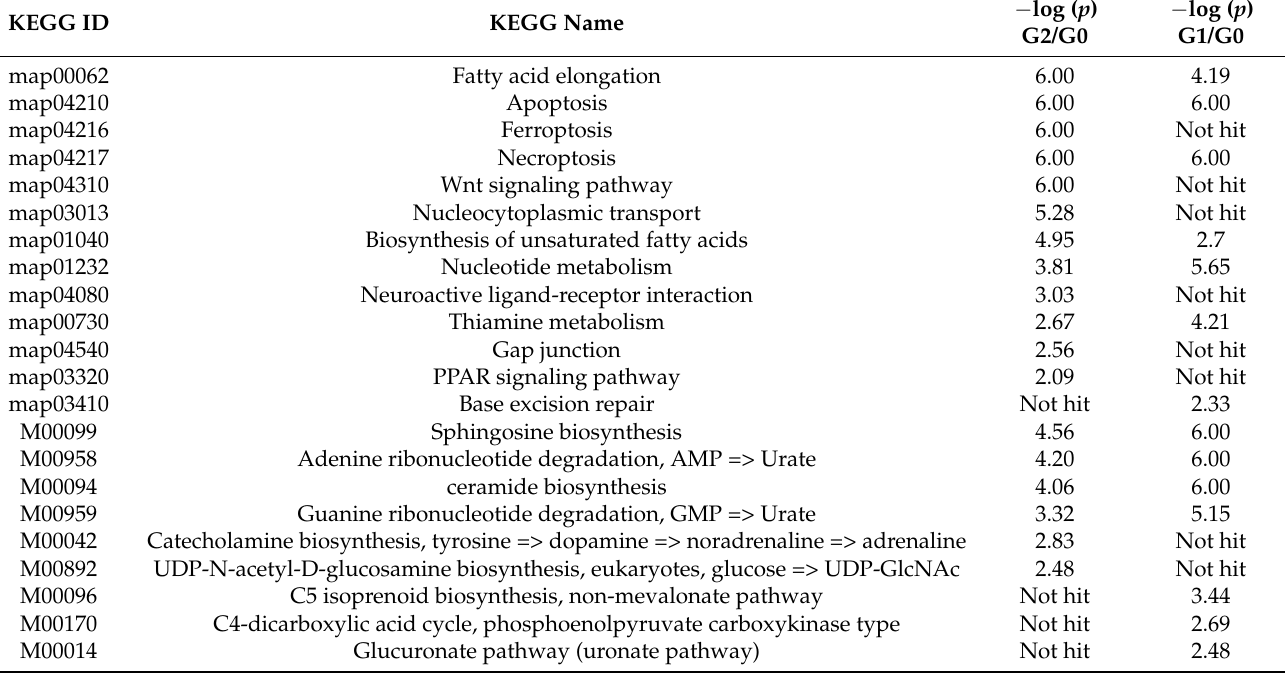
Table 1. Enrichment of differential metabolites invoked by alcohol (G2/G0 and G1/G0).